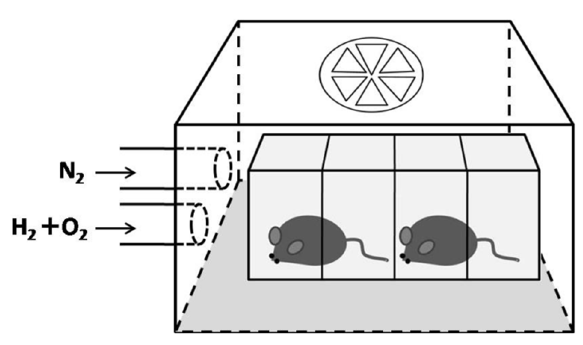
Figure 7. The setting of the inhalation